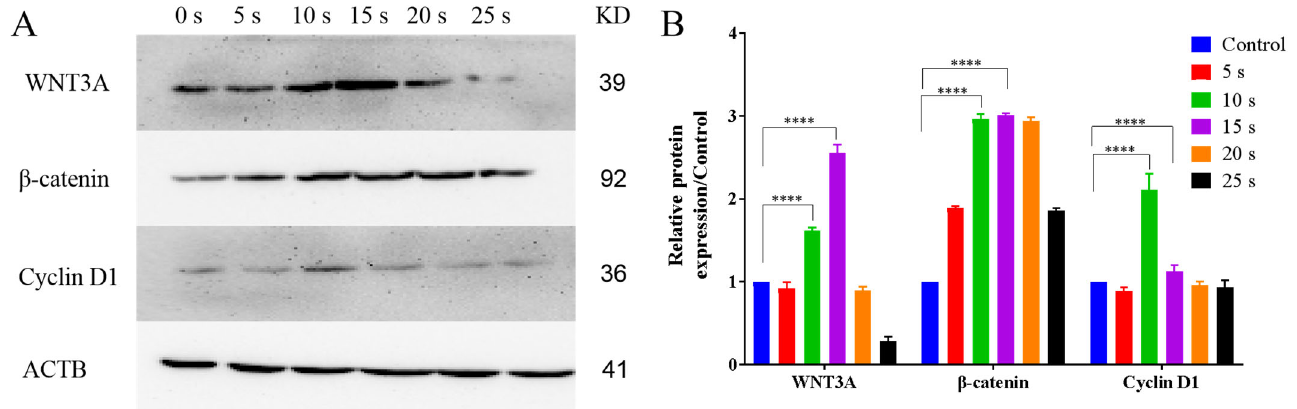
Figure 8. NTP activated the WNT3A/ β ‐ catenin pathways in HaCaT cells. ( A ) The expression of WNT3A, β ‐ catenin, and Cyclin D1 were determined by WB. ( B ) The protein expression quantification measured with Photoshop software. Data represent the mean ± SD of three independent experiments. **** p < 0.0001 with ANOVA compared with the control.